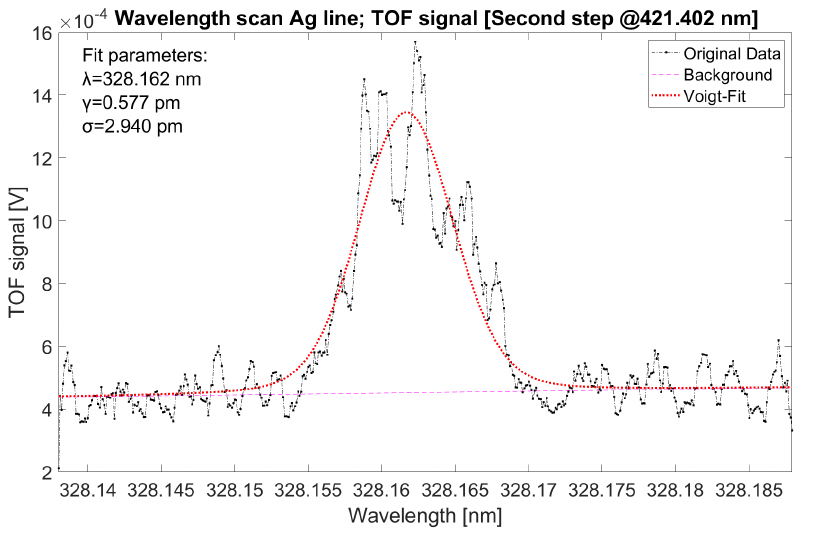
Figure 8. First-step Doppler broadening; scanned with second-step laser, operating as a multi-mode laser with central frequency @421.402 nm Scanning range = 50 pm (139.2 GHz).